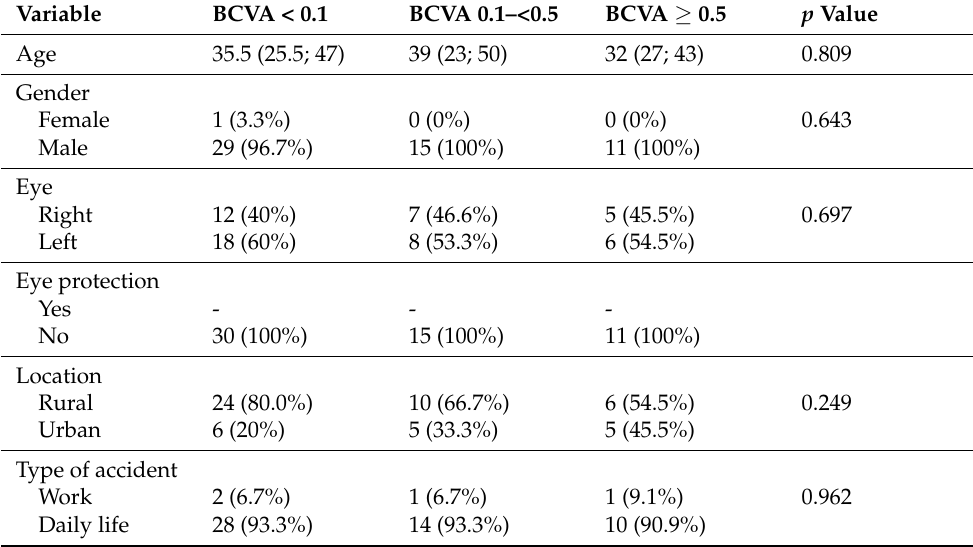
Table 1. Demographic data of